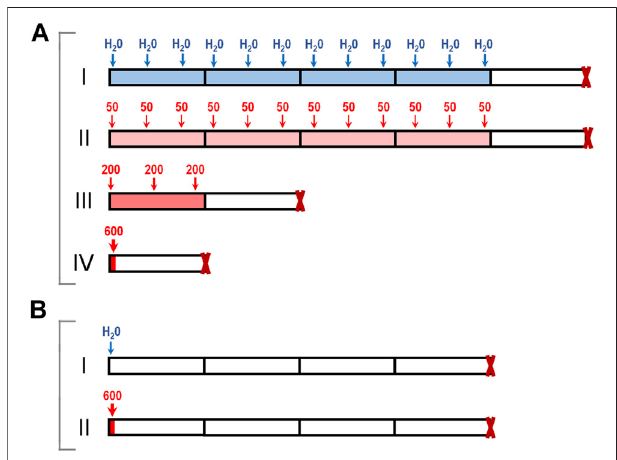
FIGURE 1 | Toxicology study of 7-MG: schematic representation of experiments. (A) CBA mice were treated either with water (group I) or with singleandmultipledosesof7-MG(groupsII – IV,totaldoseforeachgroupwas 600 mg/kg); (B) CBA, BALB/c, or C57BL/6 mice were treated with water(groupsI)orasingle600 mg/kgdoseof7-MG(groupII),andeuthanized 4 weeks